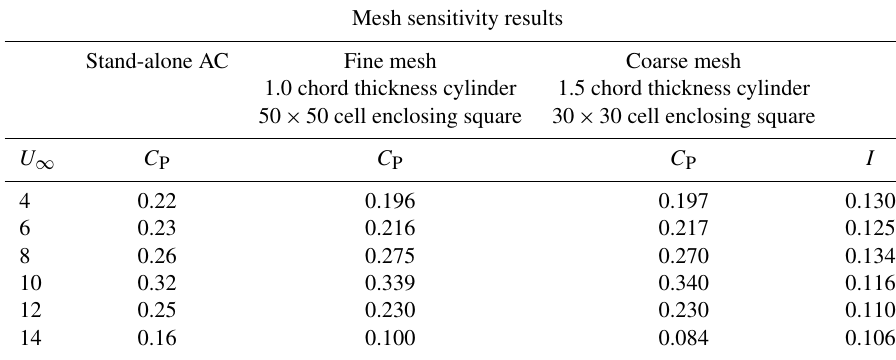
Table 2. RANS-AC results from two different meshes verified against the stand-alone AC.